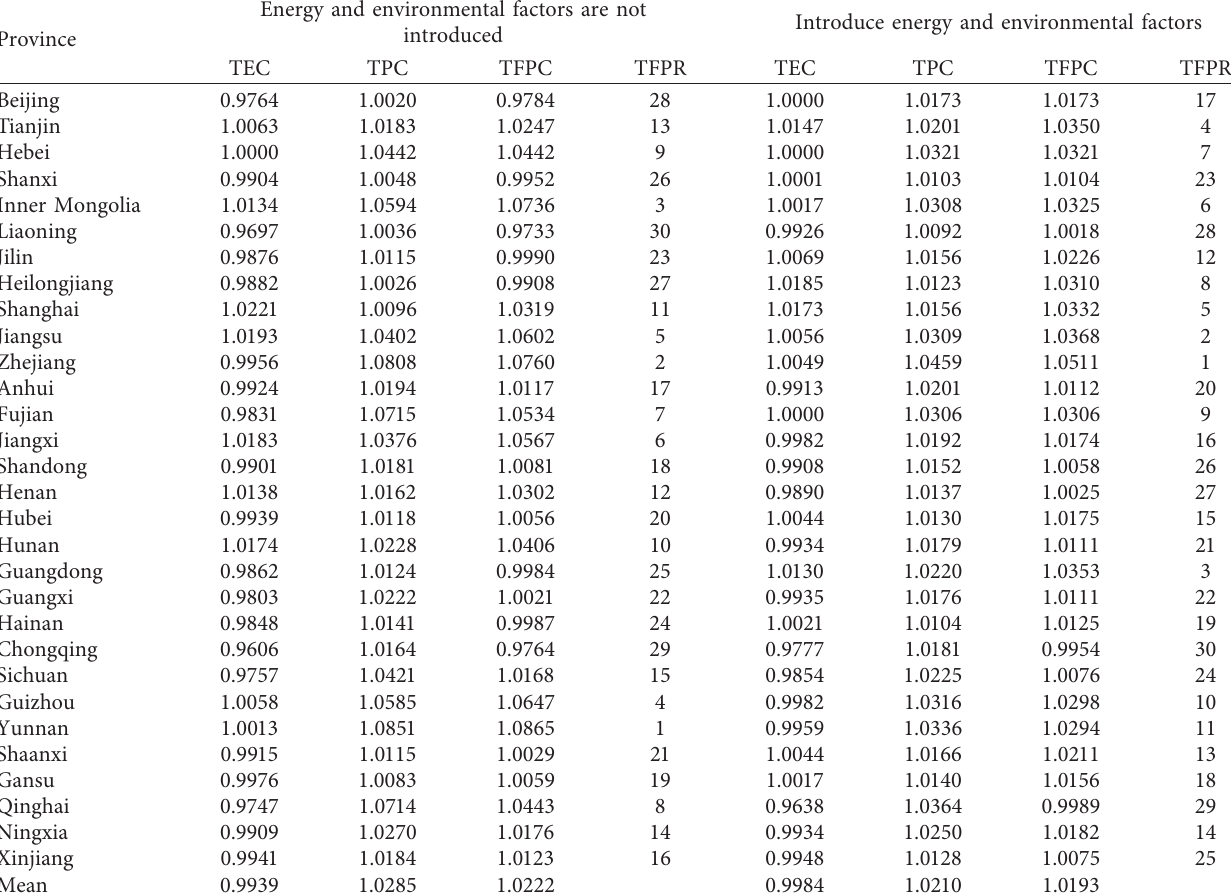
Table 5: TFP Index and its decomposition of logistics industry in all provinces of China (2003–2017). Energy and environmental factors are Province